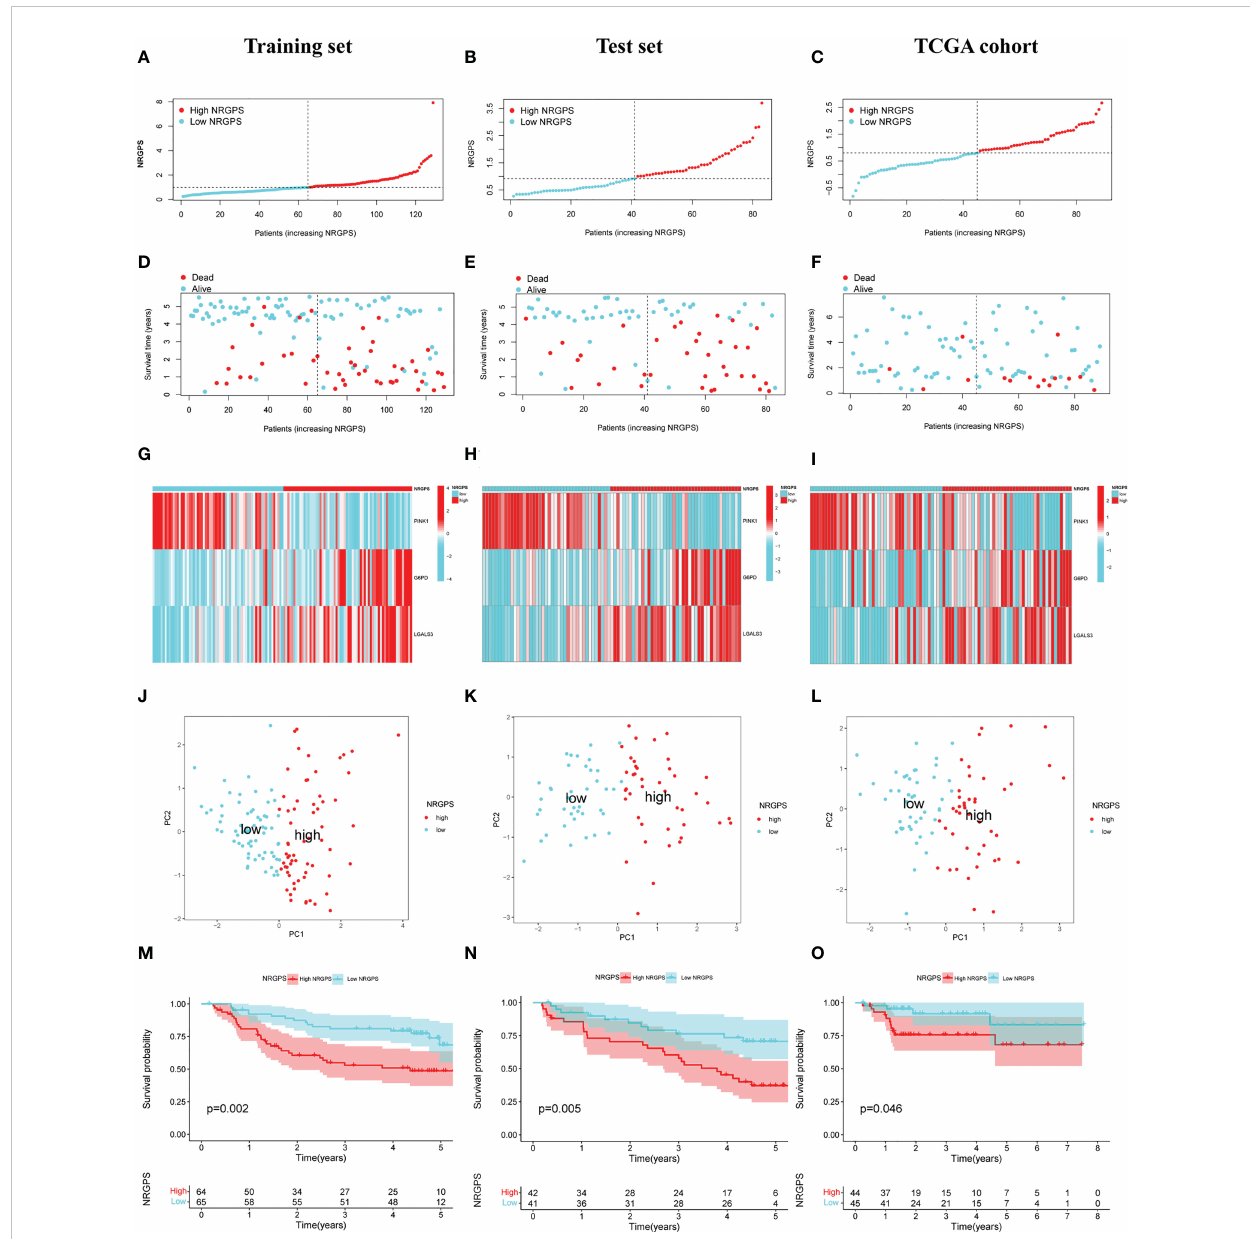
FIGURE 4 Validation of the NRGPS System. (A – C) The graphs of Training set, Test set and TCGA cohort. (D – F) The scatter plots of Training, Test set and TCGA cohort. (G – I) The expression of 3 DENRGs in high and low NRGPS. (J – L) PCA analysis in Training set, Test set and TCGA cohort. (M – O) Kaplan- meier survival analysis in Training set, Test set and TCGA cohort. NRGPS, necroptosis-related gene prognostic score; DENRGs, differentially expressed necroptosis-related